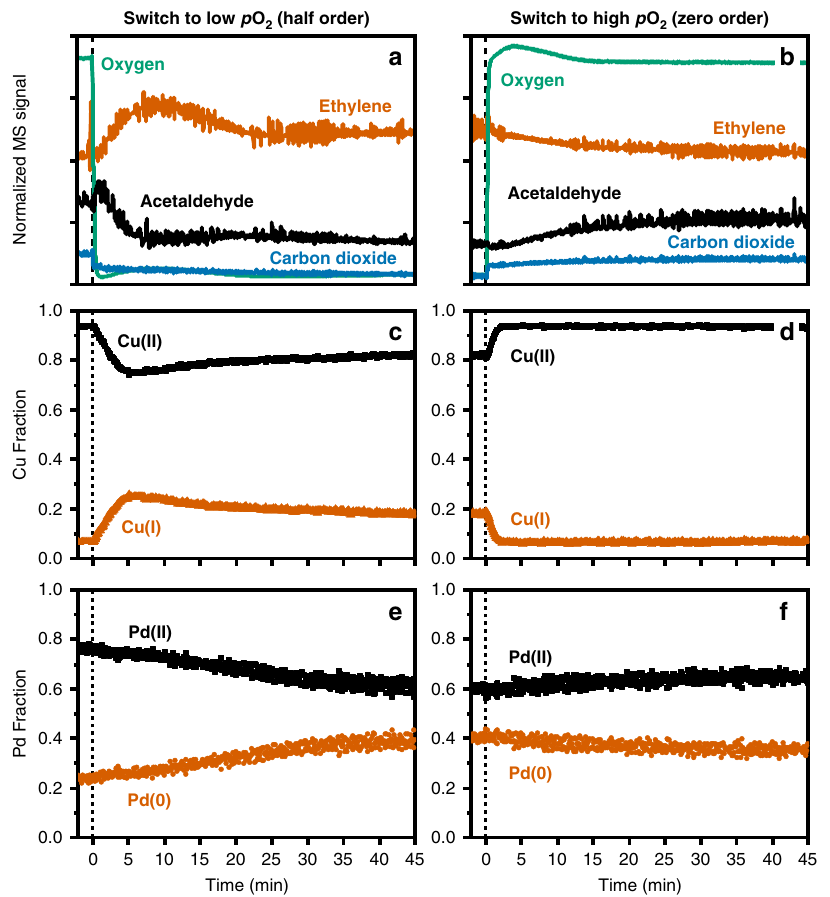
Fig. 4 Transient oxygen switching experiments. a , b Normalized mass spectrometry (MS) signals of outlet gas components as a function of time during the transient oxygen switching experiments over Pd1Cu5-Y. Corresponding dynamic c , d copper and e , f palladium speciation determined from MCR-ALS of time-resolved XANES spectra. The fraction of Cu(II) species is the sum of hydrated and dehydrated copper species, the speciation of which are shown in Supplementary Figs. 13 – 16. The catalyst was equilibrated under Wacker conditions for 4 h before the fi rst change in oxygen partial pressure ( t < 0). After changing the partial pressure of oxygen (zero order to half order and back), the catalyst was subjected to the gas feed until the MS signals equilibrated. This kinetic regime switching experiment was carried out two more times and the results are provided in full detail in Supplementary Figs. 13 – 16. Gas